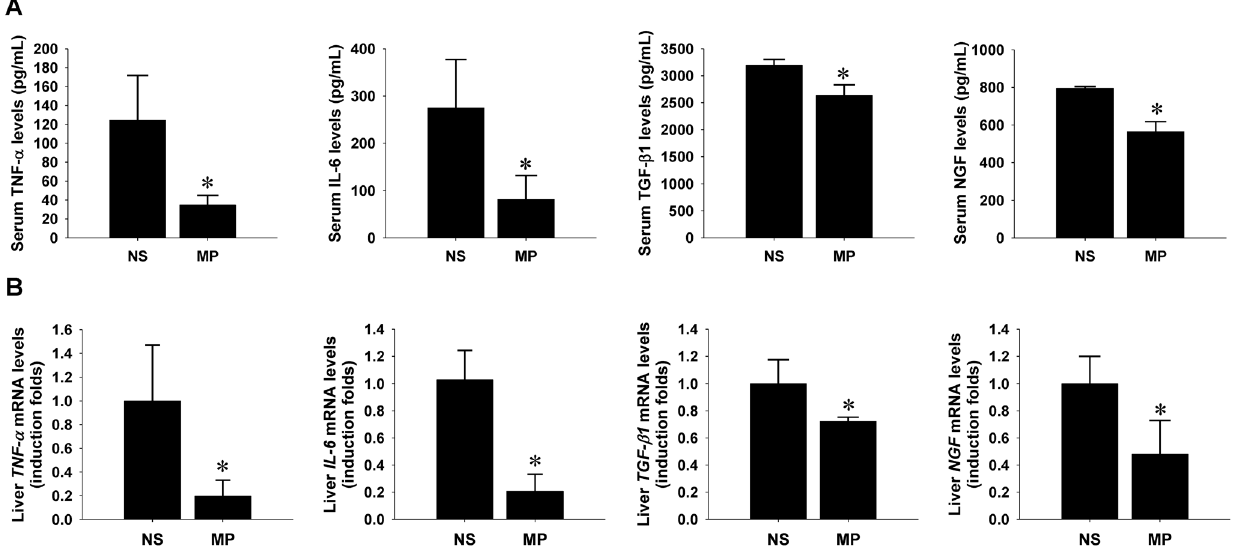
Figure 3. Amelioration of systemic inflammation and NGF up-regulation in cholestatic liver-bearing mice by methylprednisolone (MP). The mice receiving bile duct ligation surgery immediately underwent intraperitoneal administration with either normal saline (NS, n=5) or MP (n=3) at 1 mg/kg/day for 14 consecutive days. Mice plasma and liver extracts were collected and subjected to ELISA (A) and RT-qPCR analyses (B), respectively. Inflammatory cytokines measured included TNF- a , IL-6, NGF, and TGF- b 1. Data are shown in mean 6 SEM. * indicates P , 0.05 compared to NS group.